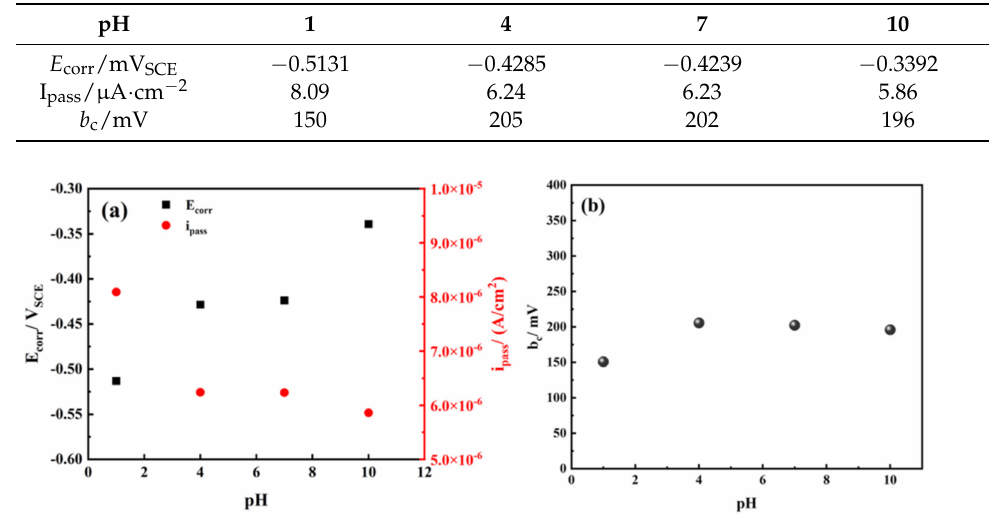
Figure 2. Variations in ( a ) corrosion potential E corr and passive current density i pass , ( b ) cathodic Tafel slope b c obtained from potentiodynamic polarization curves of TA2 in simulated seawater with different pH